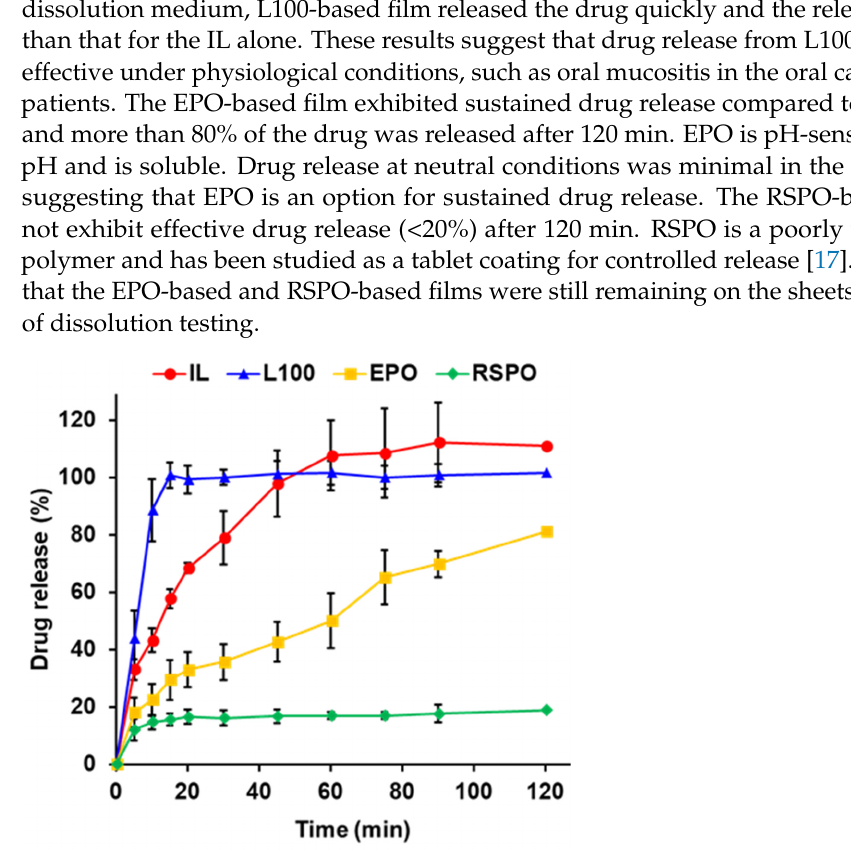
Figure 6. Drug release from 3D-printed films comprising different Eudragit polymers and an IL. Details of the drug dissolution test and the drug formulations used are described in Section 2 and Table 1, respectively. These data represent the means ± standard deviations ( n =